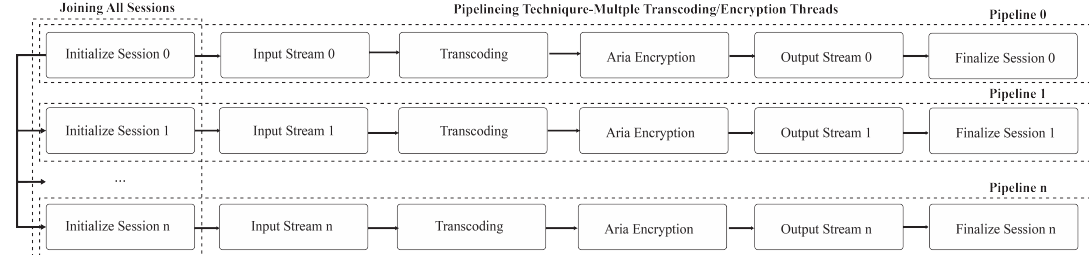
Figure 6. Multiple real-time streaming over transcoder box.